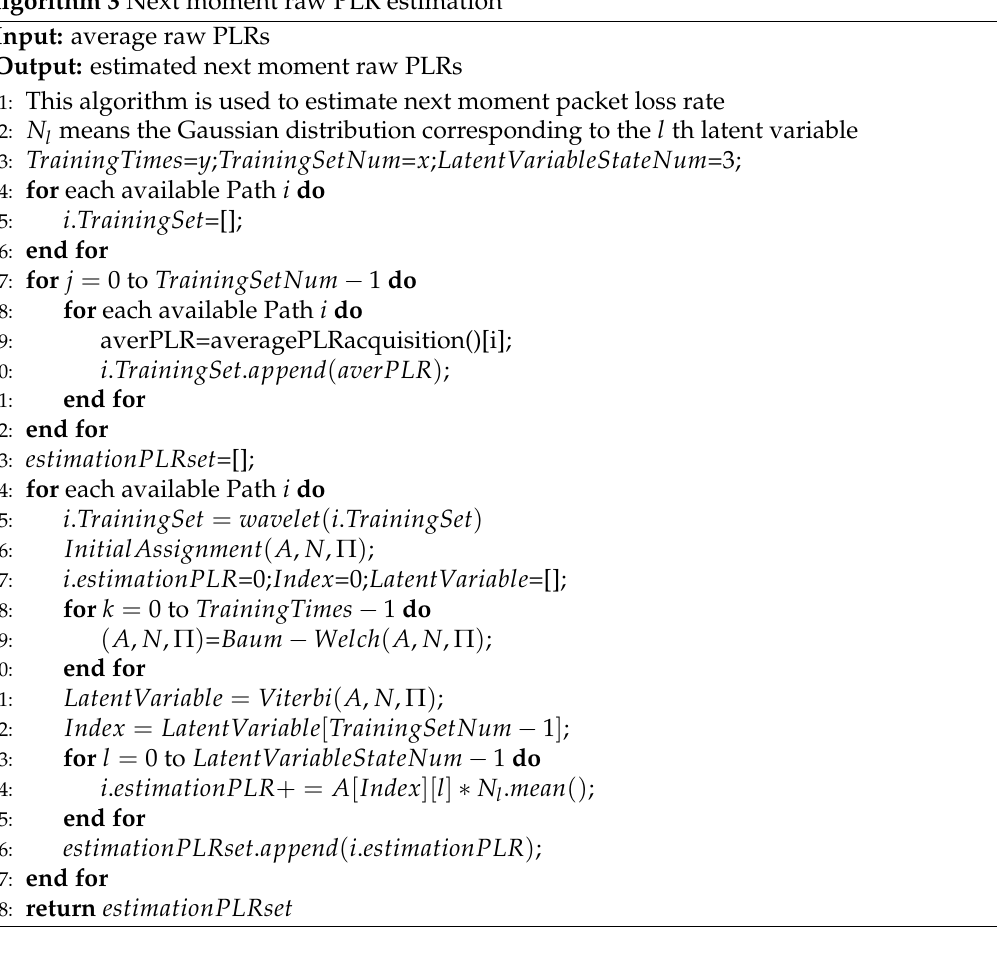
Algorithm 3 Next moment raw PLR estimation